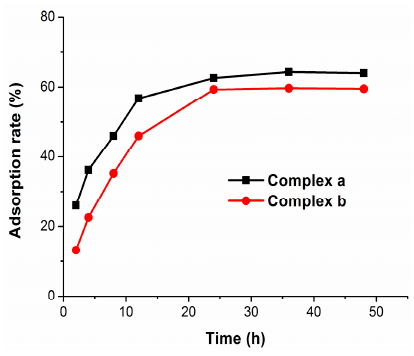
Figure 2. Adsorption curves of complexes a and b onto HA.